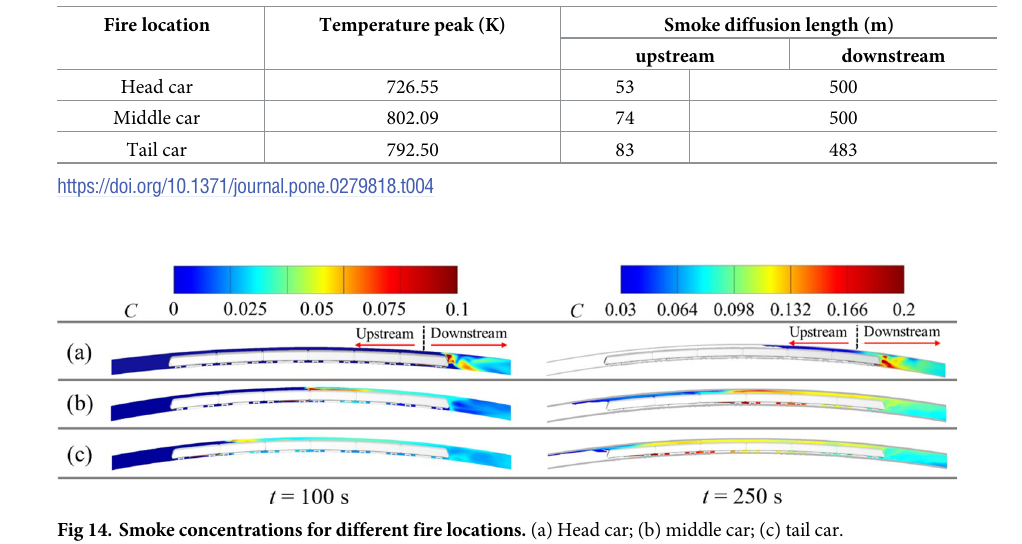
Table 4. Temperatures for different fire locations at t = 250 s.